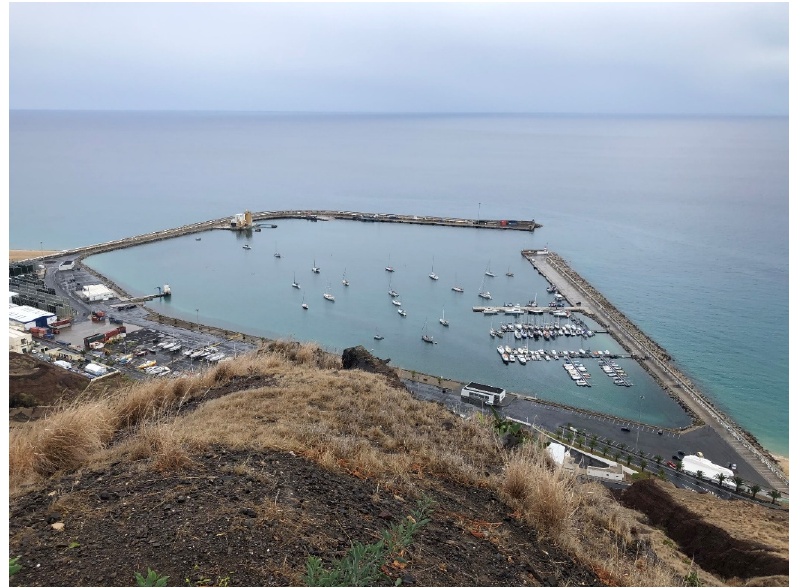
Figure 4. Port of Porto Santo Island. (Source: Authors).